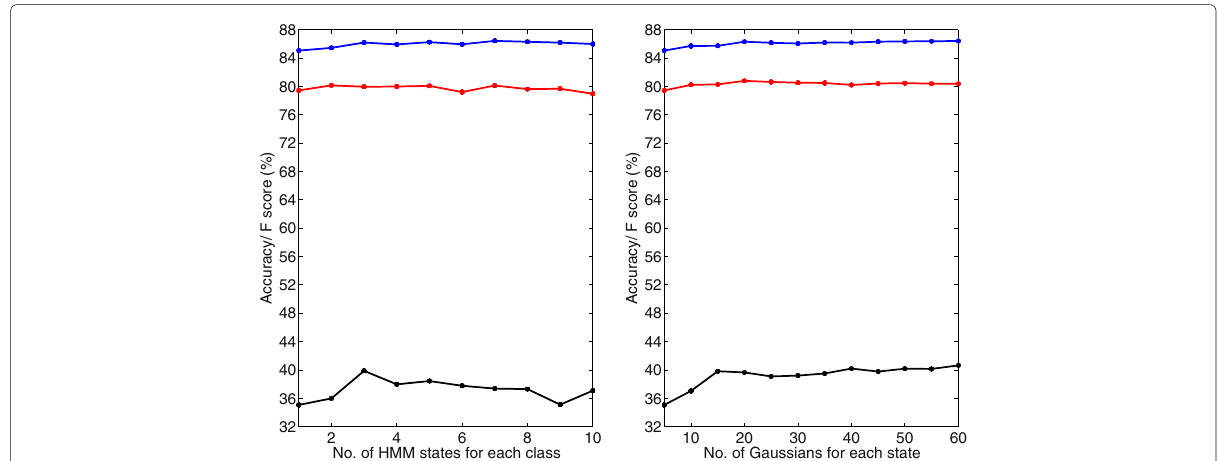
Fig. 10 The left plot shows the variation of segmentation performance for different number of HMM states per target class, using five Gaussians for each state. The right plot shows the same for different number of Gaussians for each state, using single HMM state per target class. The blue plot depicts the variation in system accuracy, while red and black plots depicting variation in F scores for expiratory and inspiratory phases,